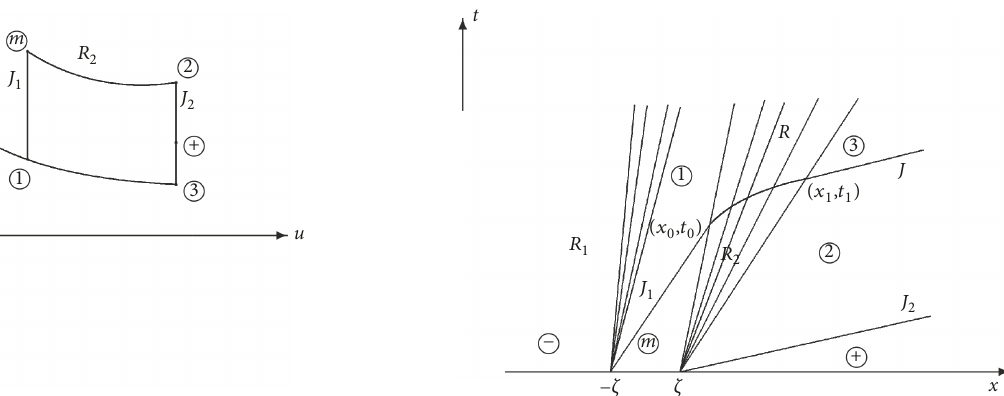
Figure 3: Wave interactions as 𝑢 + > 𝑢 𝑚 > 𝑢 −